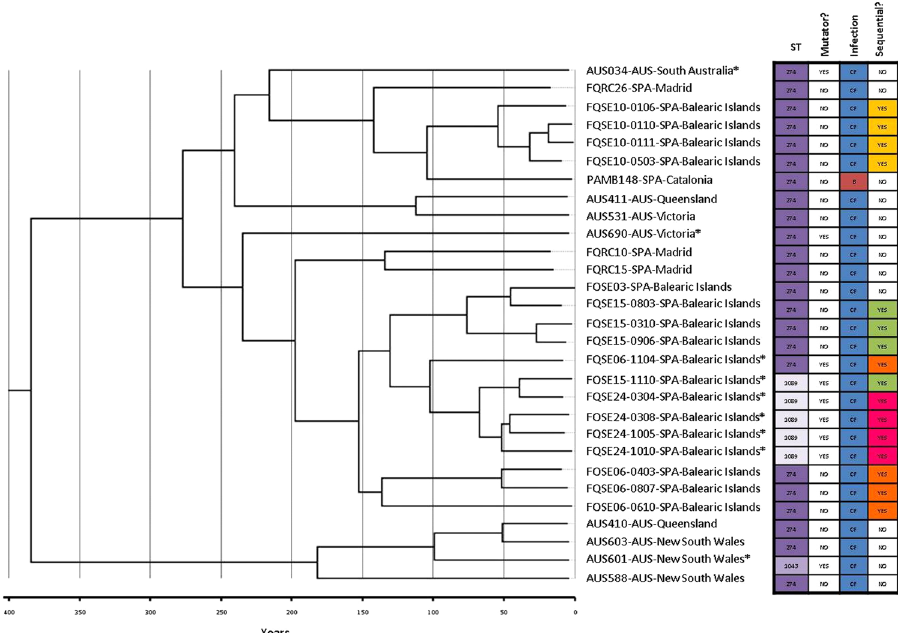
Figure 3. Bayesian phylogenetic reconstruction of P . aeruginosa CC274 CF clone. The tree was based on 5525 intraclonal variable positions identified by whole-genome sequencing. Divergence times of predicted ancestors and sampling dates can be inferred from the X axis taking into account that time zero corresponds to the most recent isolate (2012). The same labelling of Fig. 2 was used. Isolates characteristics are summarized at the right board, where: (CF) Cystic Fibrosis CRI and (B) Bloodstream. Sequential P . aeruginosa isolated from a same patient are indicated with the same